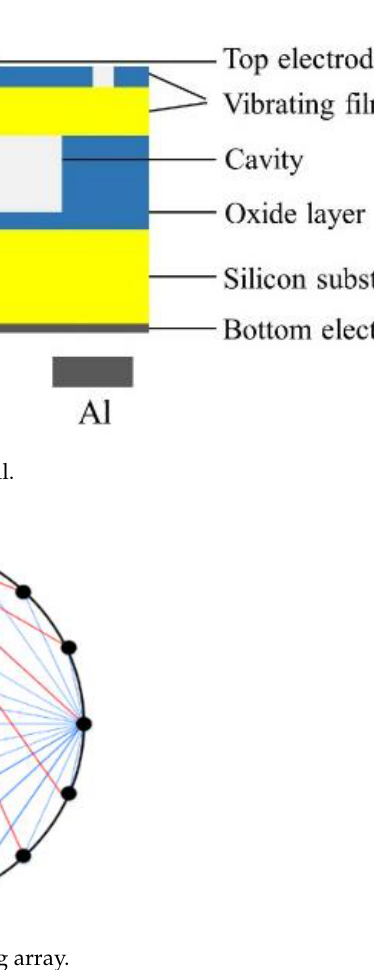
Figure 1. Ultrasonic tomography system based on a CMUT cylindrical array.